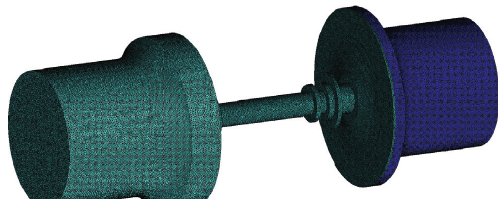
Figure 2: Global grid for conjugate heat transfer calculation.